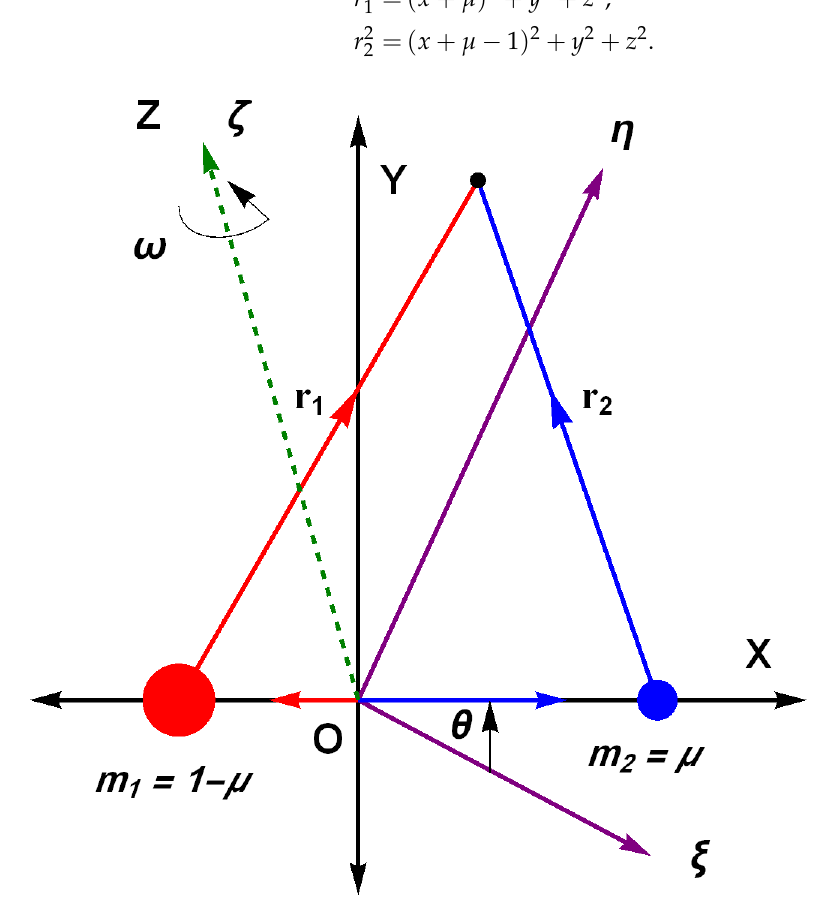
Figure 1. Configuration of the Earth–Moon system as the restricted three-body